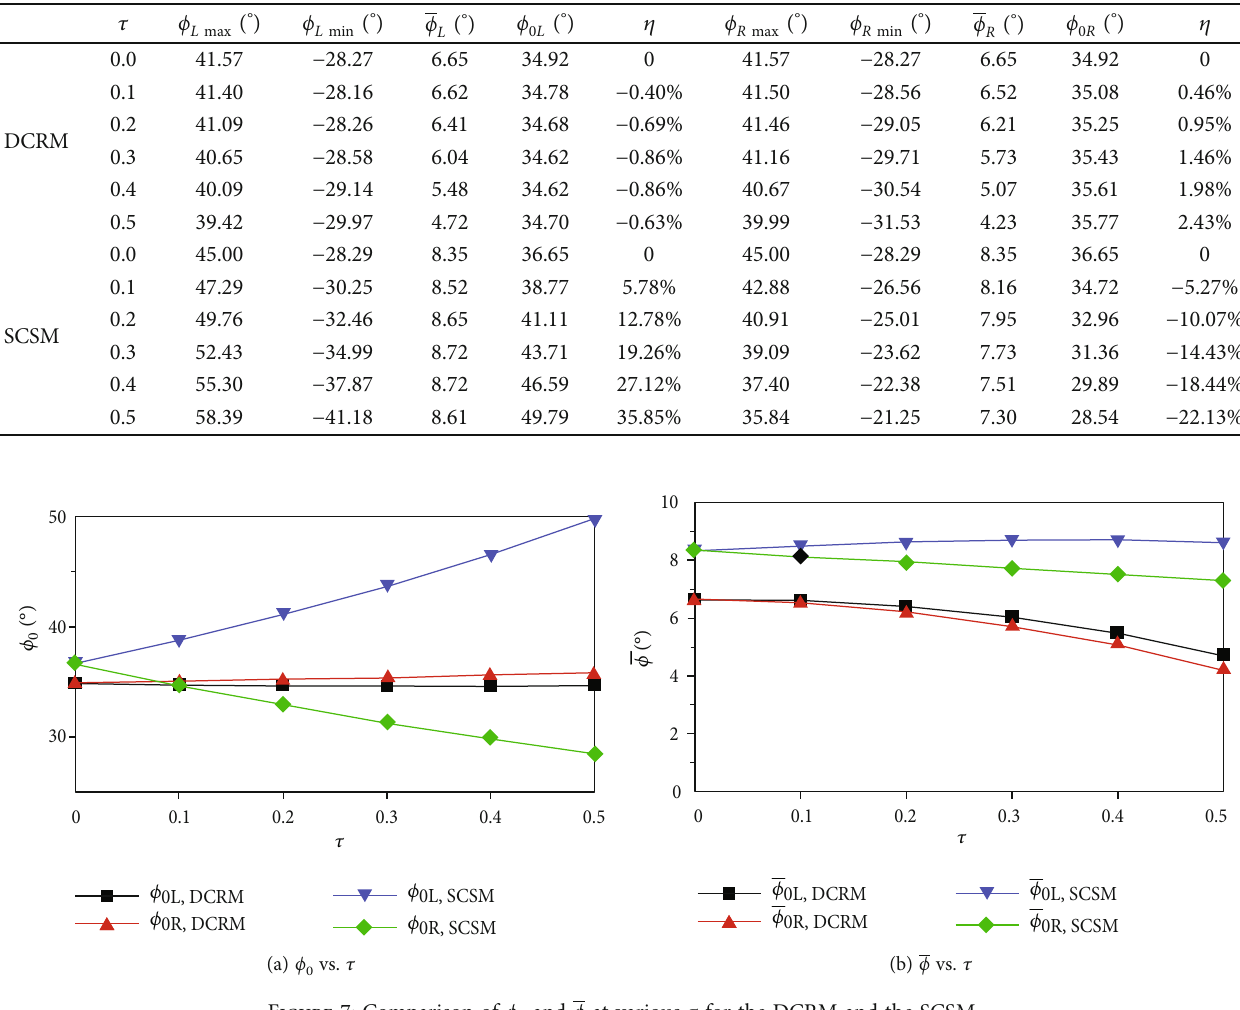
Table 2: Maximums, minimums, means, and amplitudes of ϕ